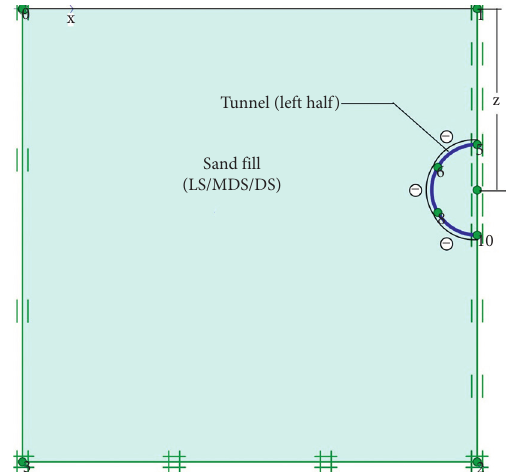
Figure 1: Model cross section. Model is created with fixities all around and filled inside with sands of different denseness under homogeneous condition. Left half of the tunnel is placed at depth “ z